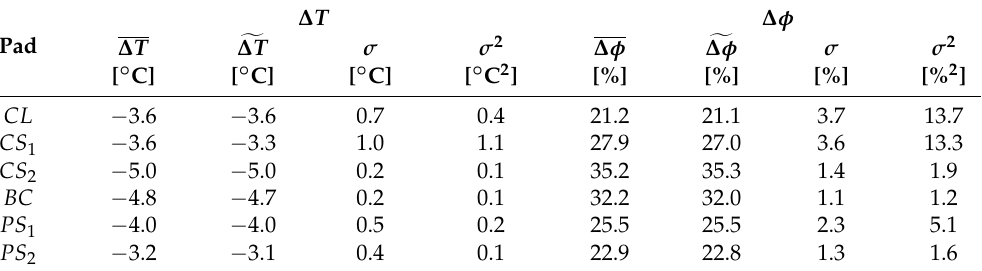
Table 5. Statistical descriptions of the change in the dry-bulb temperature ( ∆ T ) and relative humidity ( ∆ φ ) across the pads in the wind tunnel tests. ∆ T and ∆ φ are the means, (cid:102) ∆ T and (cid:102) ∆ φ are the medians, σ is the standard deviation and σ 2 is the